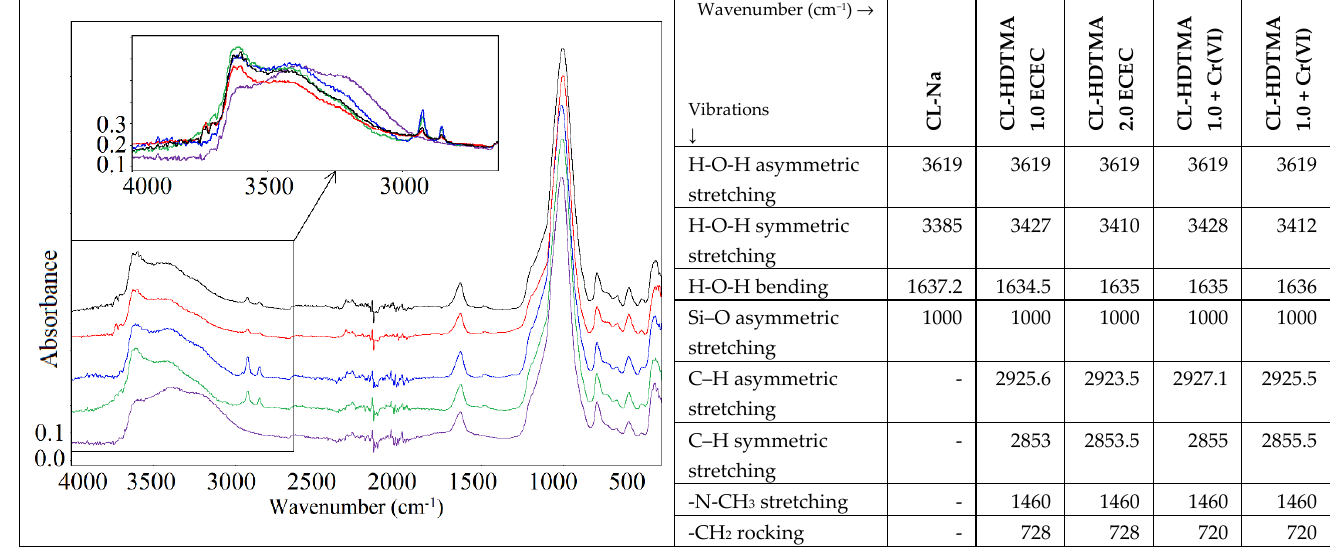
Figure 5. FTIR spectra of Na-form zeolite and SMZs before and after Cr(VI) sorption.